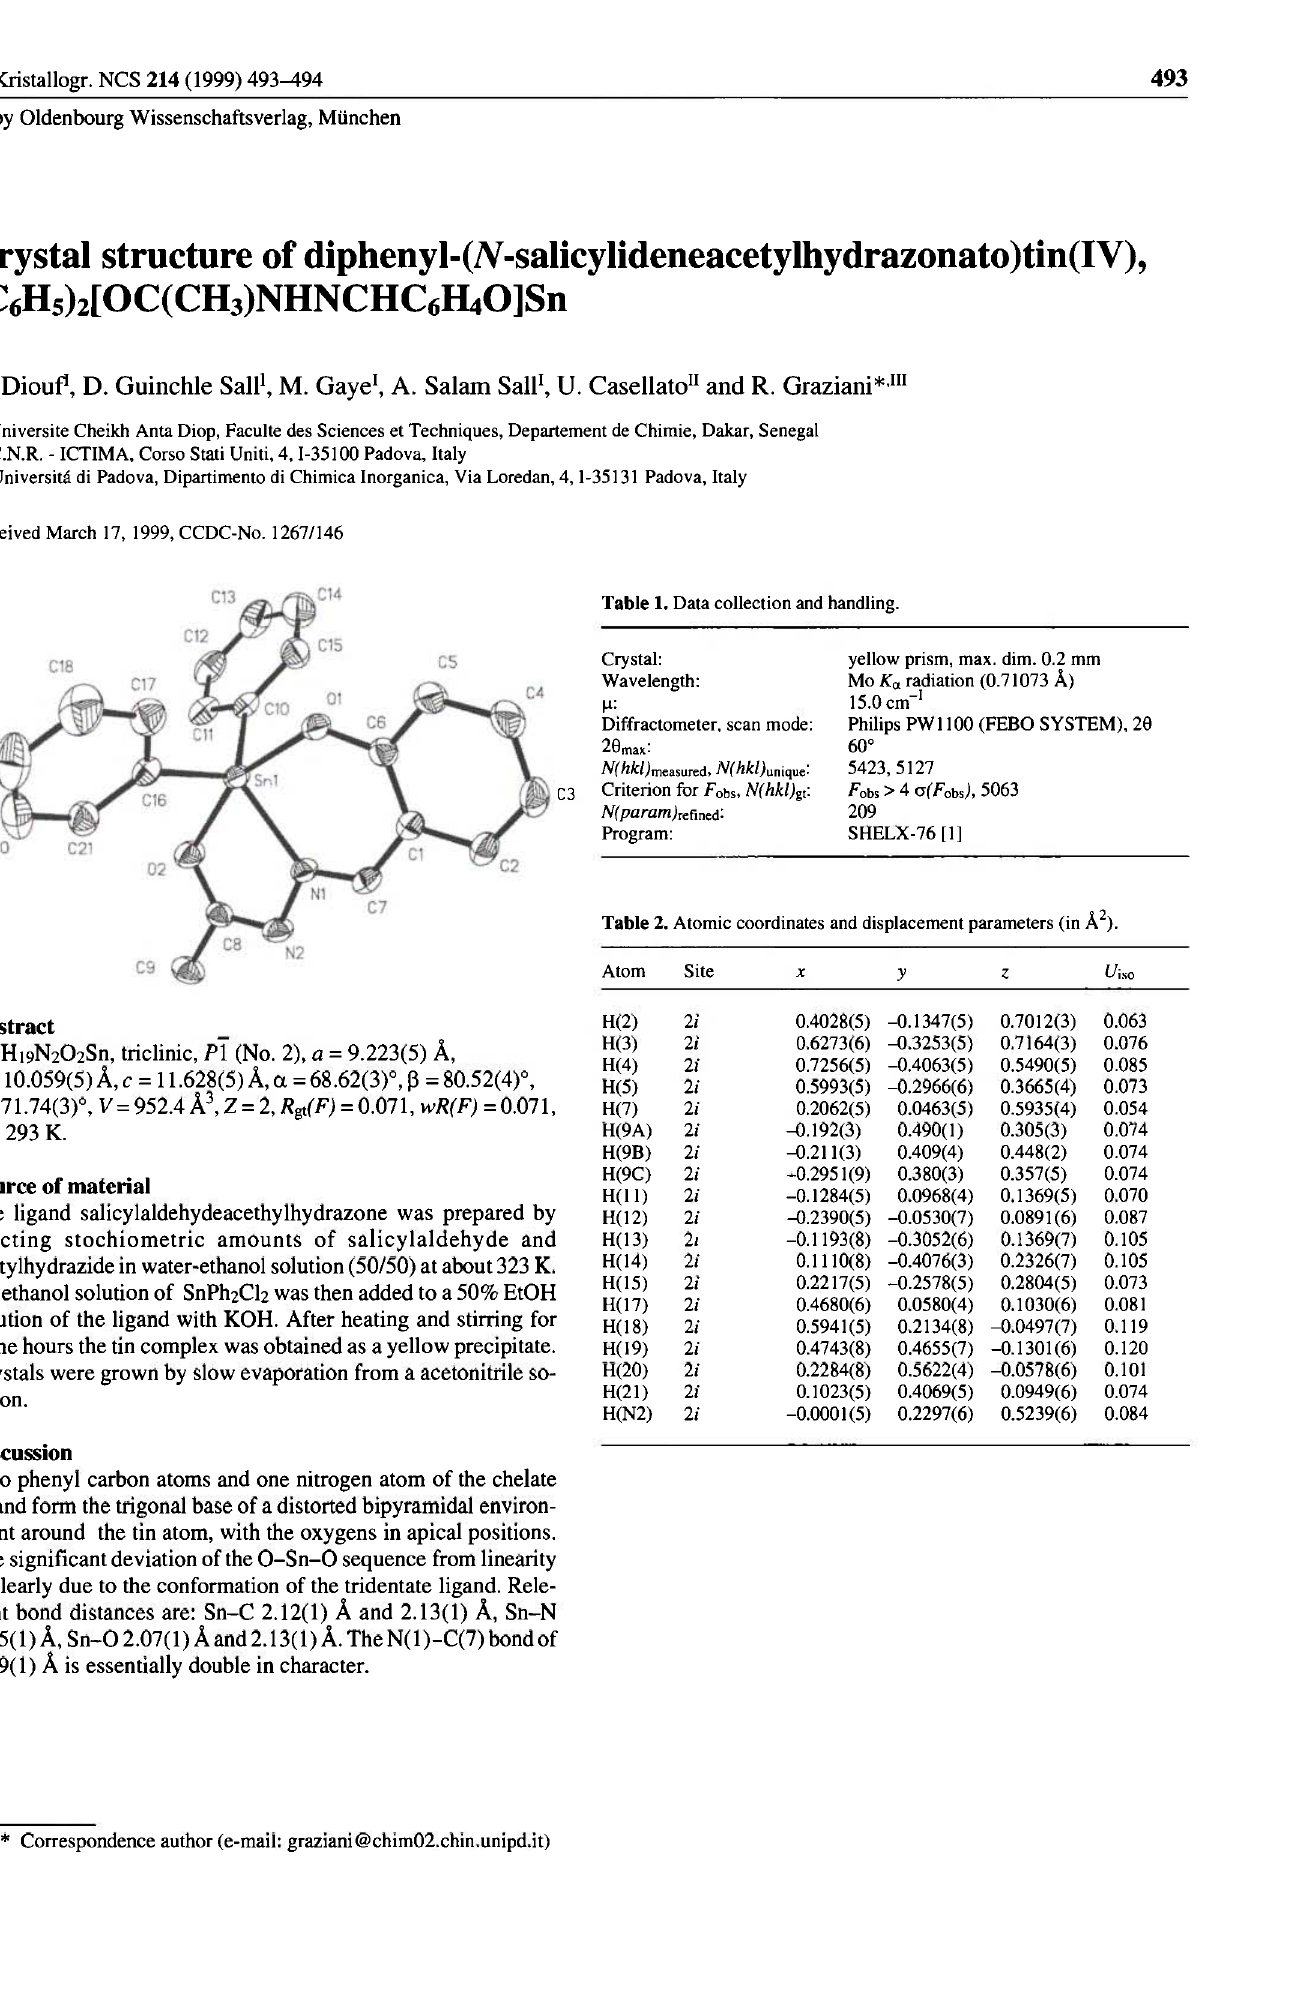
Table 1. Data collection and handling.